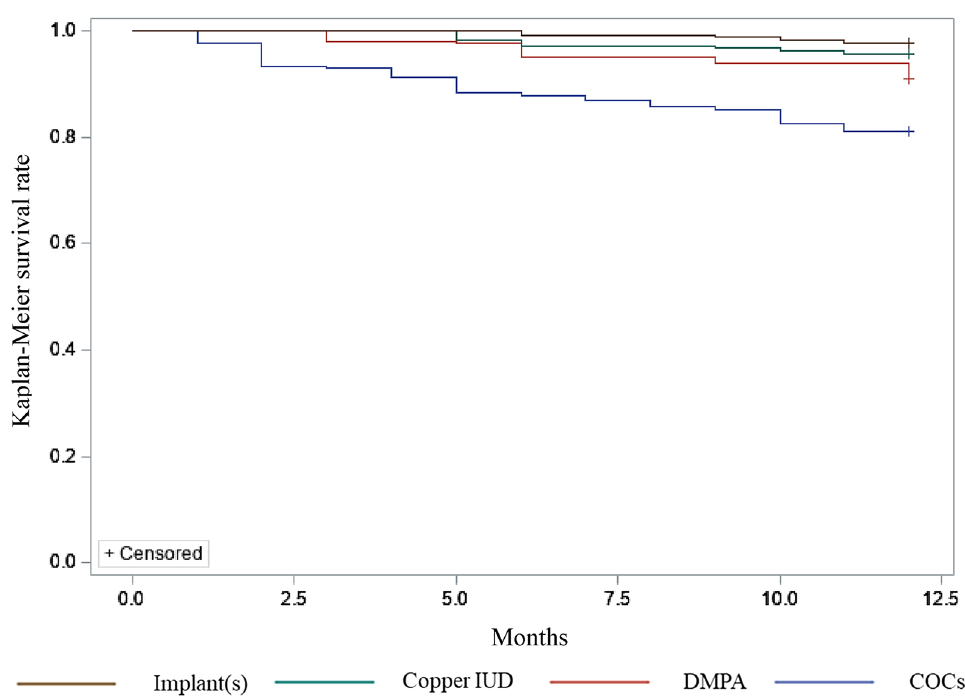
Figure 2. Kaplan–Meier survival rate of each contraceptive. From top to bottom, the top line represents contraceptive implant(s), the line below that represents copper IUD, the third line represents DMPA and the bottom line represents